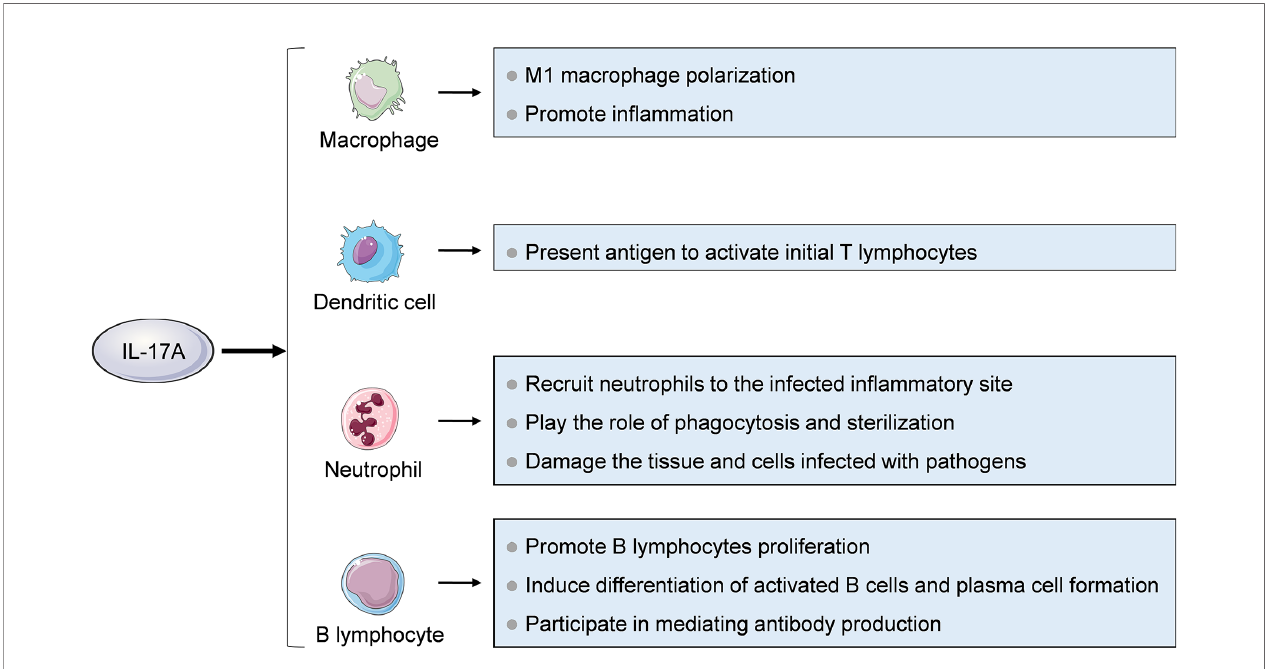
FIGURE 3 | Effects of IL-17A on immune cells. Immune cells including macrophages, neutrophils, dendritic cells and B cells are cellular targets of